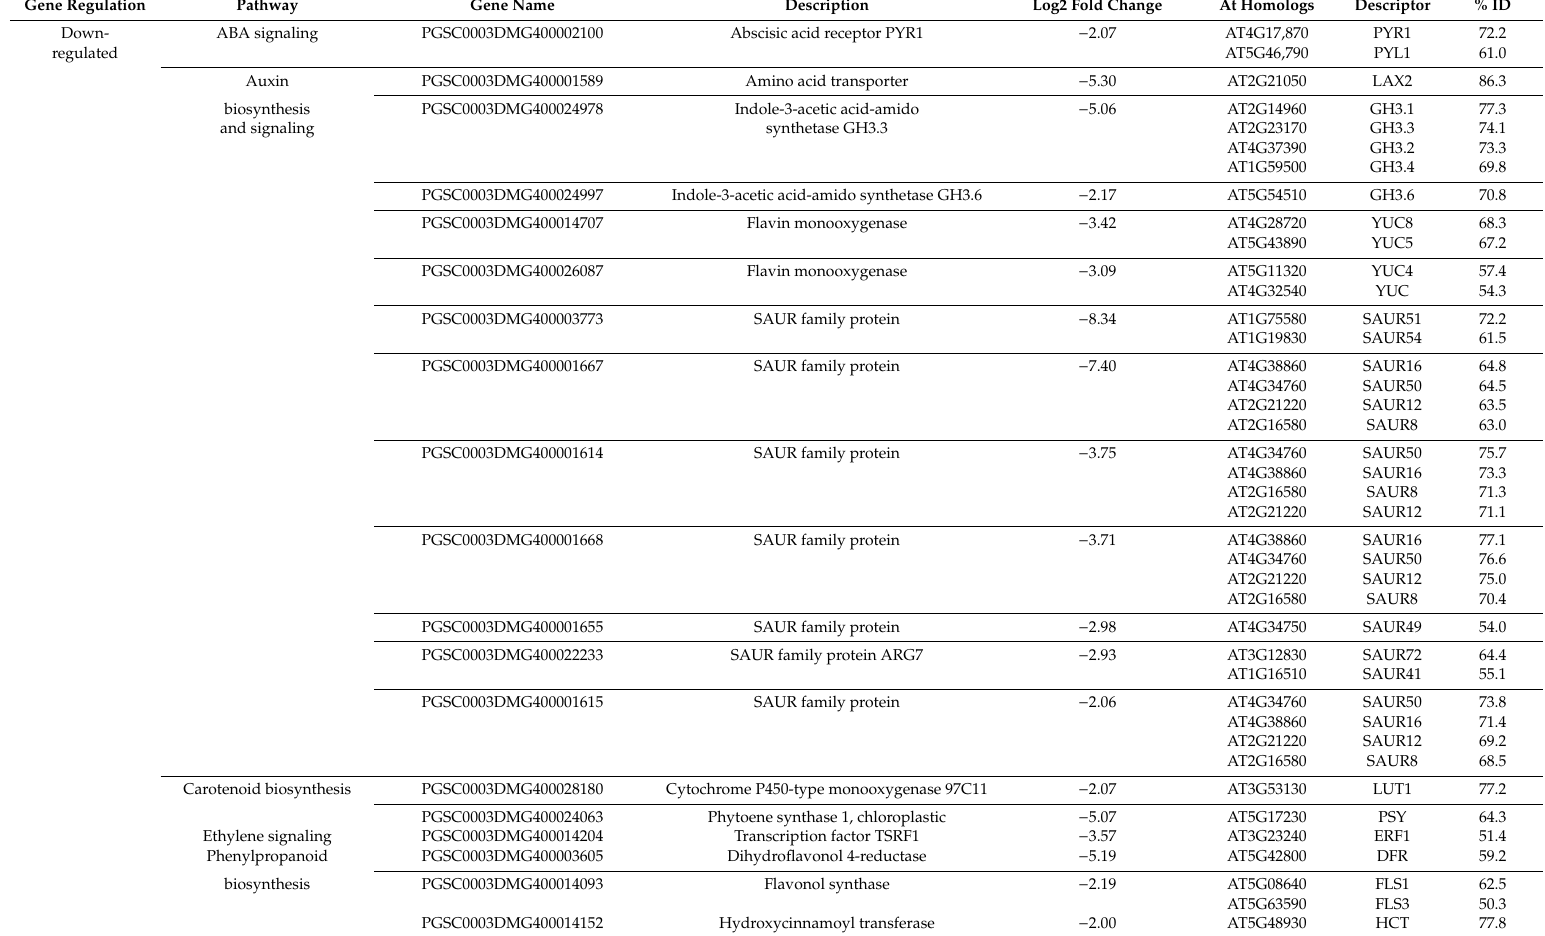
Table 2. List of di ff erentially expressed genes in drought-stressed potato tubers, the corresponding homologs in A. thaliana, and the pathway in which they participate. Pathway mapping was done based on the Arabidopsis gene names and similarities between the original S. tuberosum gene and its homolog are expressed as the percentage of identical base pairs in the gene sequences (%